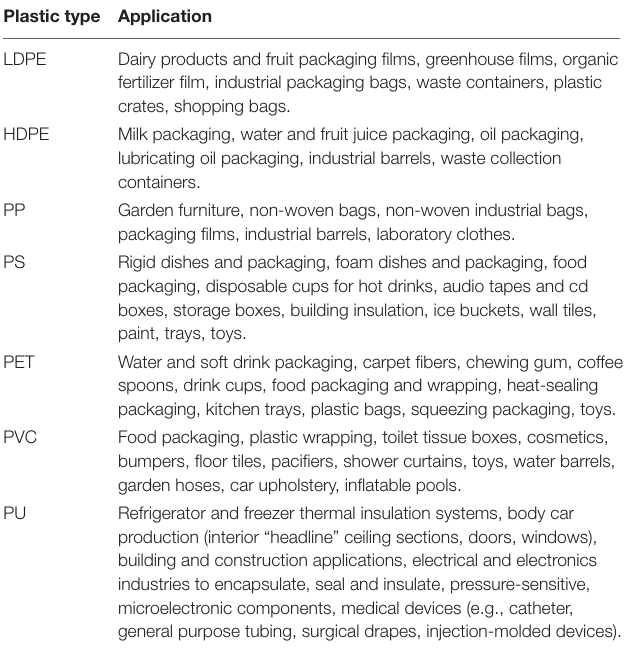
TABLE 1 | Plastics main applications (Gondal and Siddiqui, 2007).